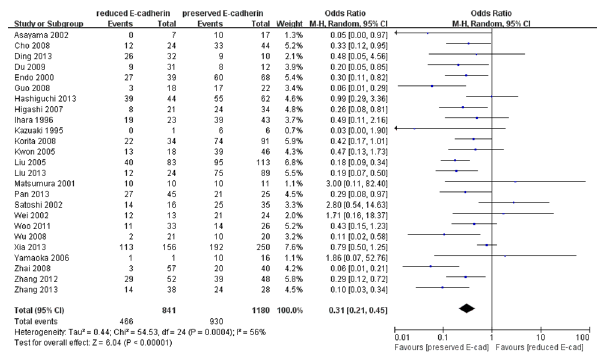
Figure 4. Forest plot displaying the results of the meta-analysis on differentiation grade.